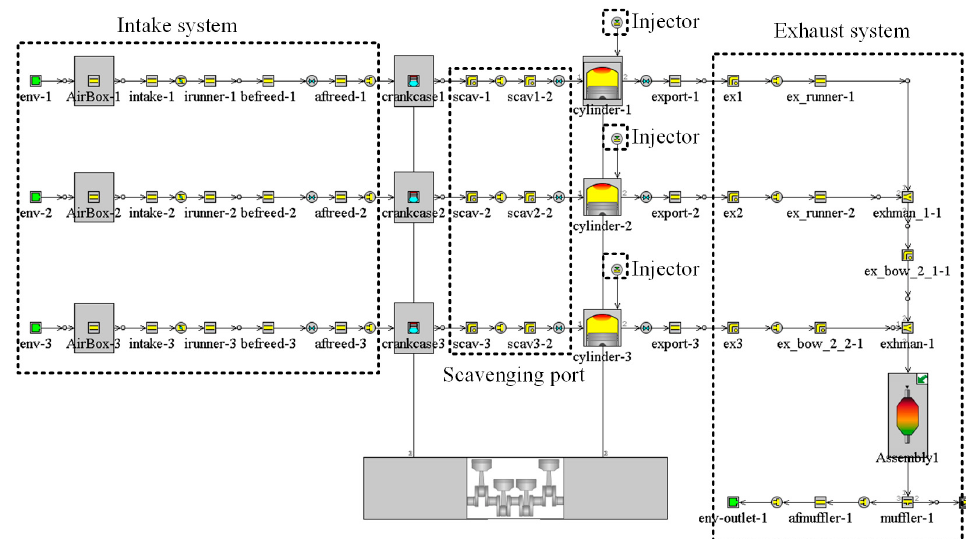
Figure 5. One-dimensional performance calculation model for the test engine.